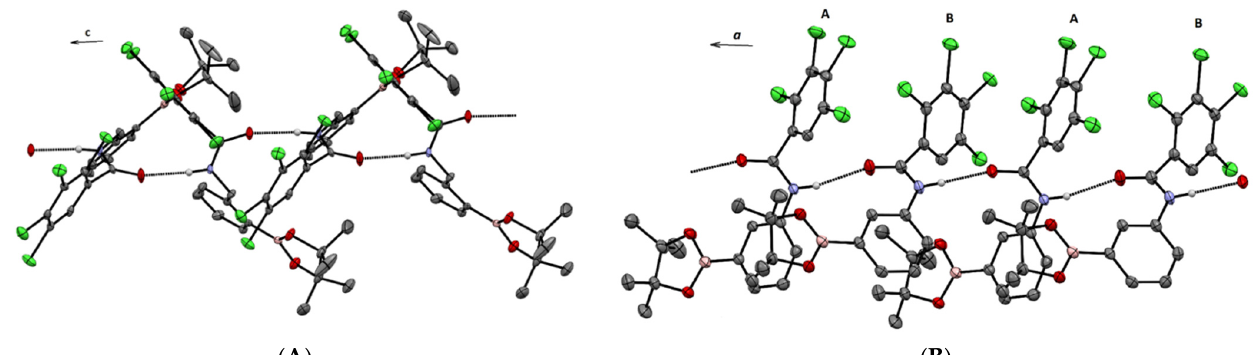
Figure 4. ( A ) H-bonding in ortho 8 and ( B ) meta 5 (molecules A and B comprise the asymmetric unit). The c and a axes respectively highlighted. Only amide H-atoms shown.